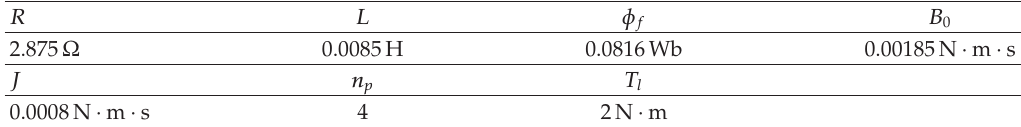
Table 1: The nominal parameters of a PMSM.